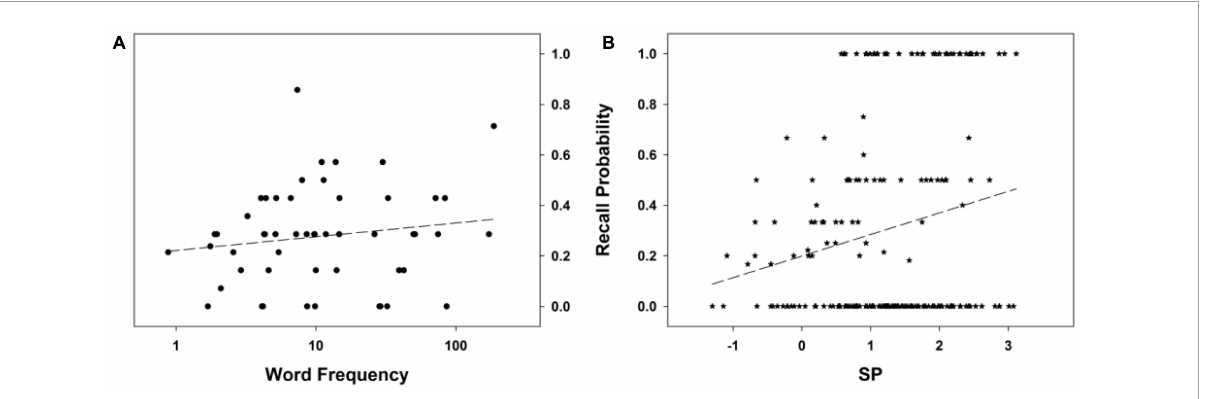
FIGURE3 Free recall probability as a function of (A) word frequency in adults (log scale), and (B) SP. The dashed line stands for the mean probability of the recall curve.